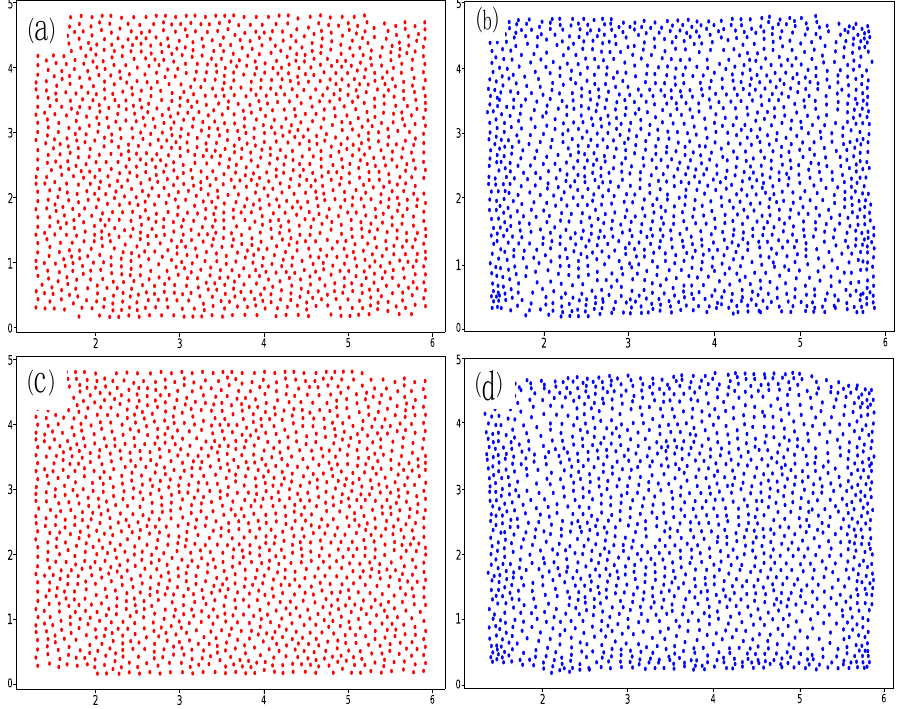
Figure 10. Granular system coordinate diagram and coordinate prediction diagram. ( a , b ) are the granular system coordinate diagram and the coordinate prediction diagram of conf3. The RMSE of conf3 is 0.0319. ( c , d ) are the granular system coordinate diagram and the coordinate prediction diagram of conf8. The RMSE of conf8 is